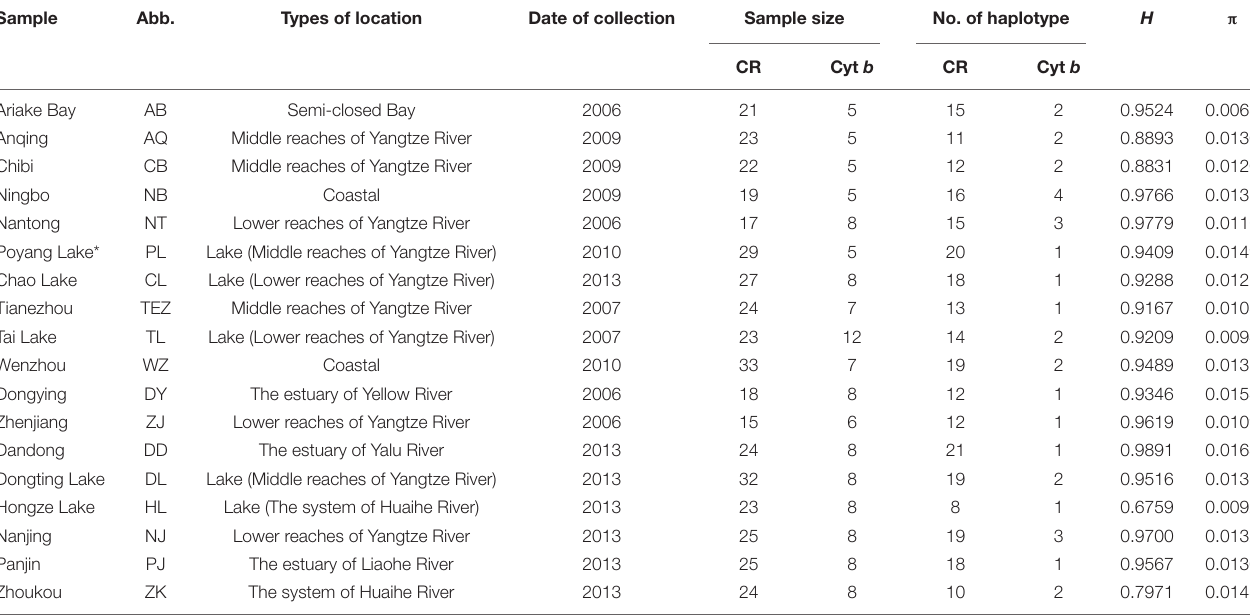
TABLE 1 | Sampling information and molecular diversity indices for the mtDNA D-loop sequences of Coilia nasus . Sample